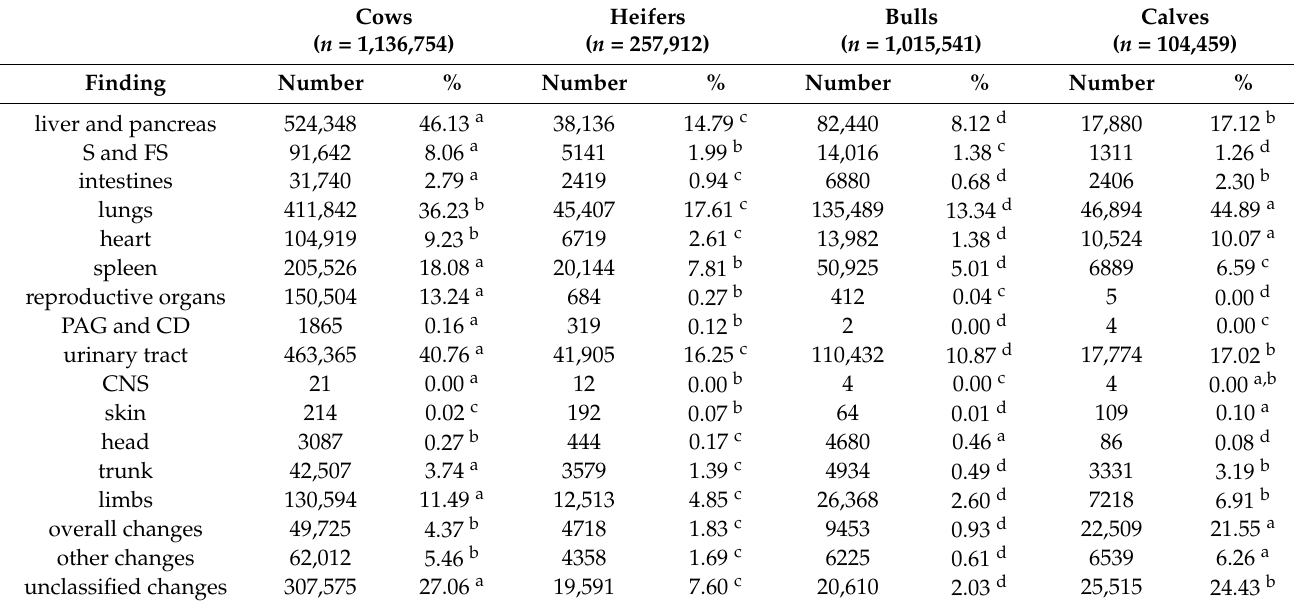
Table 1. Number of pathological findings according to their localization in individual classes of cattle.